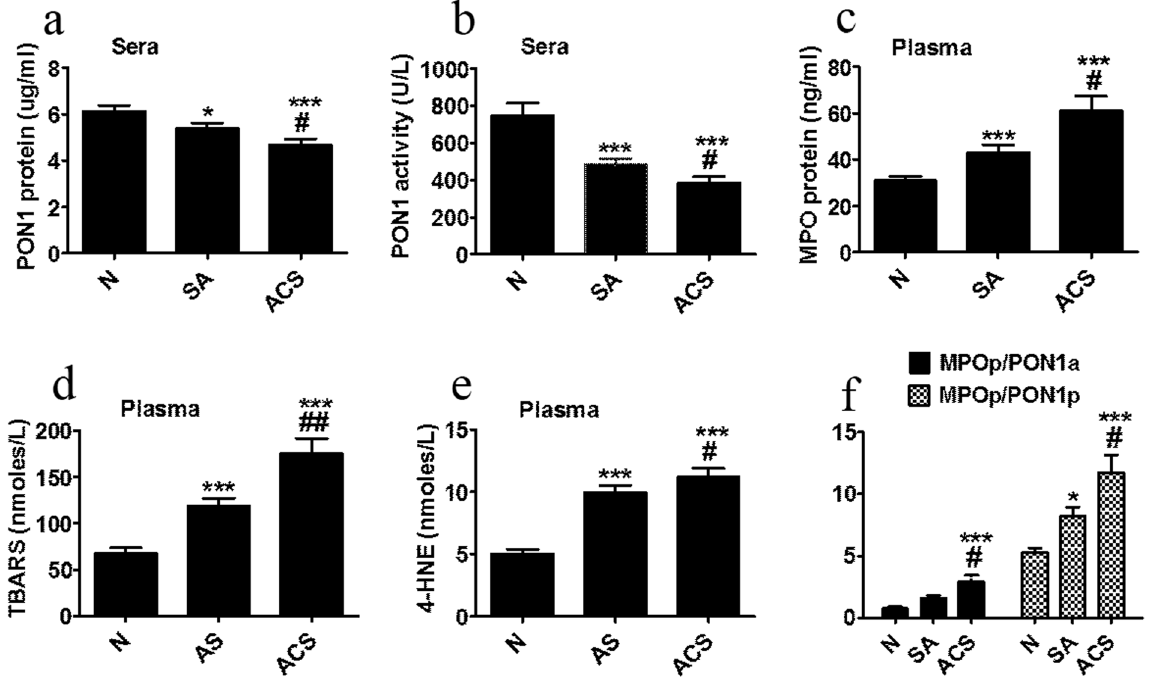
Figure 1. Biochemical parameters measured in sera/plasma of healthy subjects (N), stable angina patients (SA) and acute coronary syndrome patients (ACS). Levels of serum paraoxonase 1 (PON1) protein ( a ) and paraoxonase activity ( b ), plasma myeloperoxidase (MPO) protein ( c ), thiobarbituric reactive substances (TBARS) ( d ), free 4-hydroxy-2-nonenal (4-HNE) ( e ), and MPO protein/PON1 activity (MPOp/PON1a) and MPO protein/PON1 protein (MPOp/PON1p) ratios ( f ). Data are expressed as means ± SEM and analyzed with two-tailed Oneway ANOVA with Least Significant Difference (LSD) Post-hoc test; * p < 0.05, *** p < 0.001 vs. N; # p < 0.05, ## p < 0.01 vs SA.